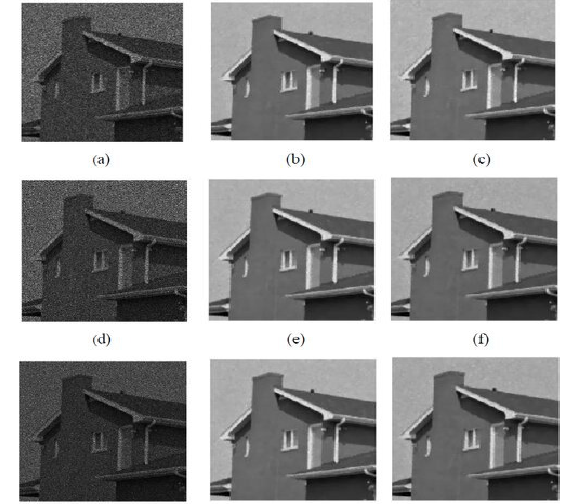
Fig. 7: Reconstructed Results nn House Image; (A) Noisy image with L 1 = 0.09 of size 256 2 ; (b) Obtained result by method M2 ( λ = 367, c =1.71) (c) Obtained result By method M1 ( λ = 482); (D) Noisy image with L 1 = 0.09 of size 320 2 ; (e) Obtained result by Method M2 ( λ = 350, c = 1.75); (f) Obtained result by Method M1 ( λ = 467); (g) Noisy image with L 1 =0.09 of size 400 2 ; (H) Obtained result by Method M2 ( λ =343, c=1.78); (I) Obtained result by method M1 ( λ = 433).